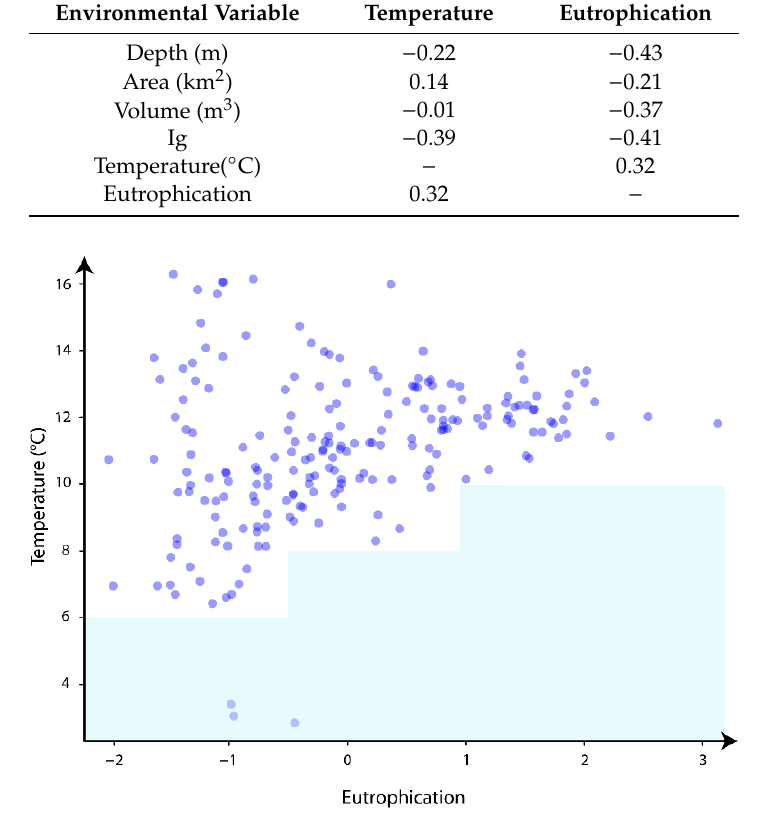
Table 2. Pearson correlation of lake characteristics with temperature and eutrophication pressures.